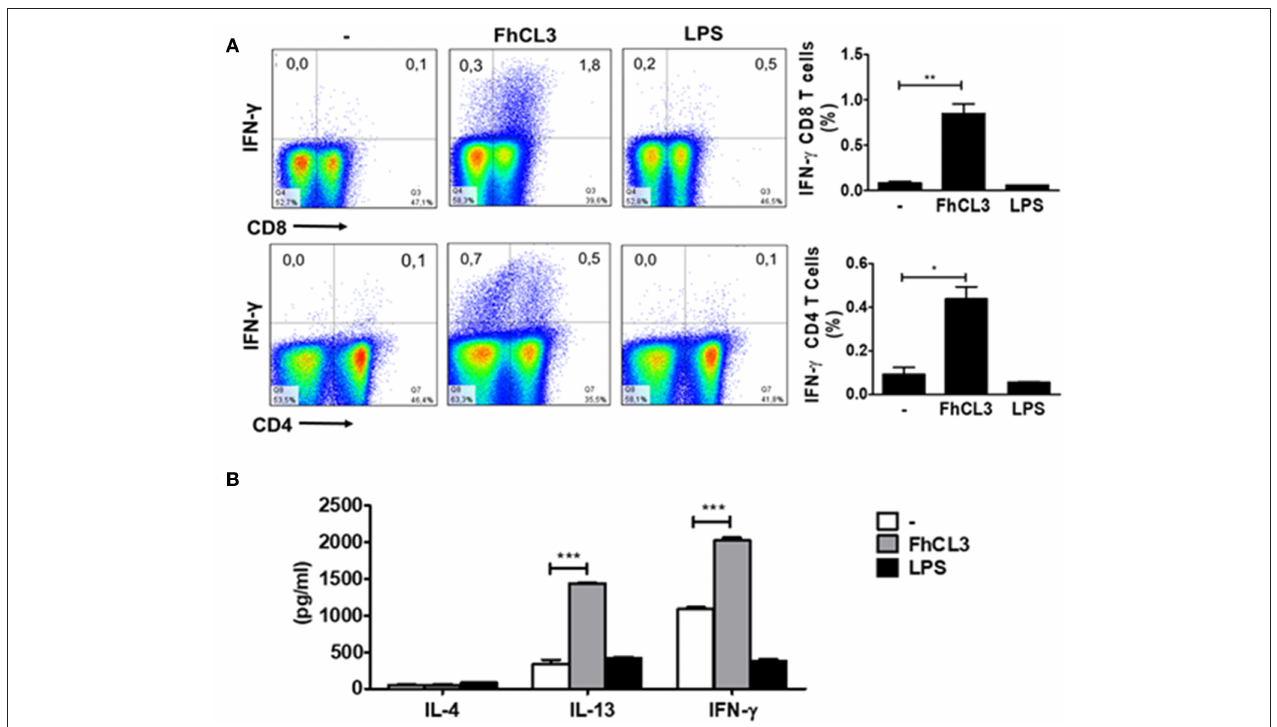
FIGURE 7 | FhCL3-treated DCs promote a specific IFN- γ response in vivo . C57BL/6 mice were injected intraperitoneally with DCs treated or not with FhCL3 or LPS. At day 7, cells from iLN were obtained and re-stimulated with FhCL3 for 48h. (A) The cells were stimulated with PMA/Ionomycin for 4h and analyzed by flow cytometry. The IFN- γ production was evaluated in CD4 + and CD8 + T cells on CD3 + gated population from inguinal lymph node. Data of flow cytometry are showed in representative dot plot diagram of three independent experiments. To the right, bar graphs depict the frequency of gated T cells. (B) The IL-4, IL-13 and IFN- γ production were evaluated in culture supernatant by ELISA. Results are presented in bars graph as means ± SD and are representative of three experiments. * p < 0.05; ** p < 0.01; *** p < 0.001 (ANOVA